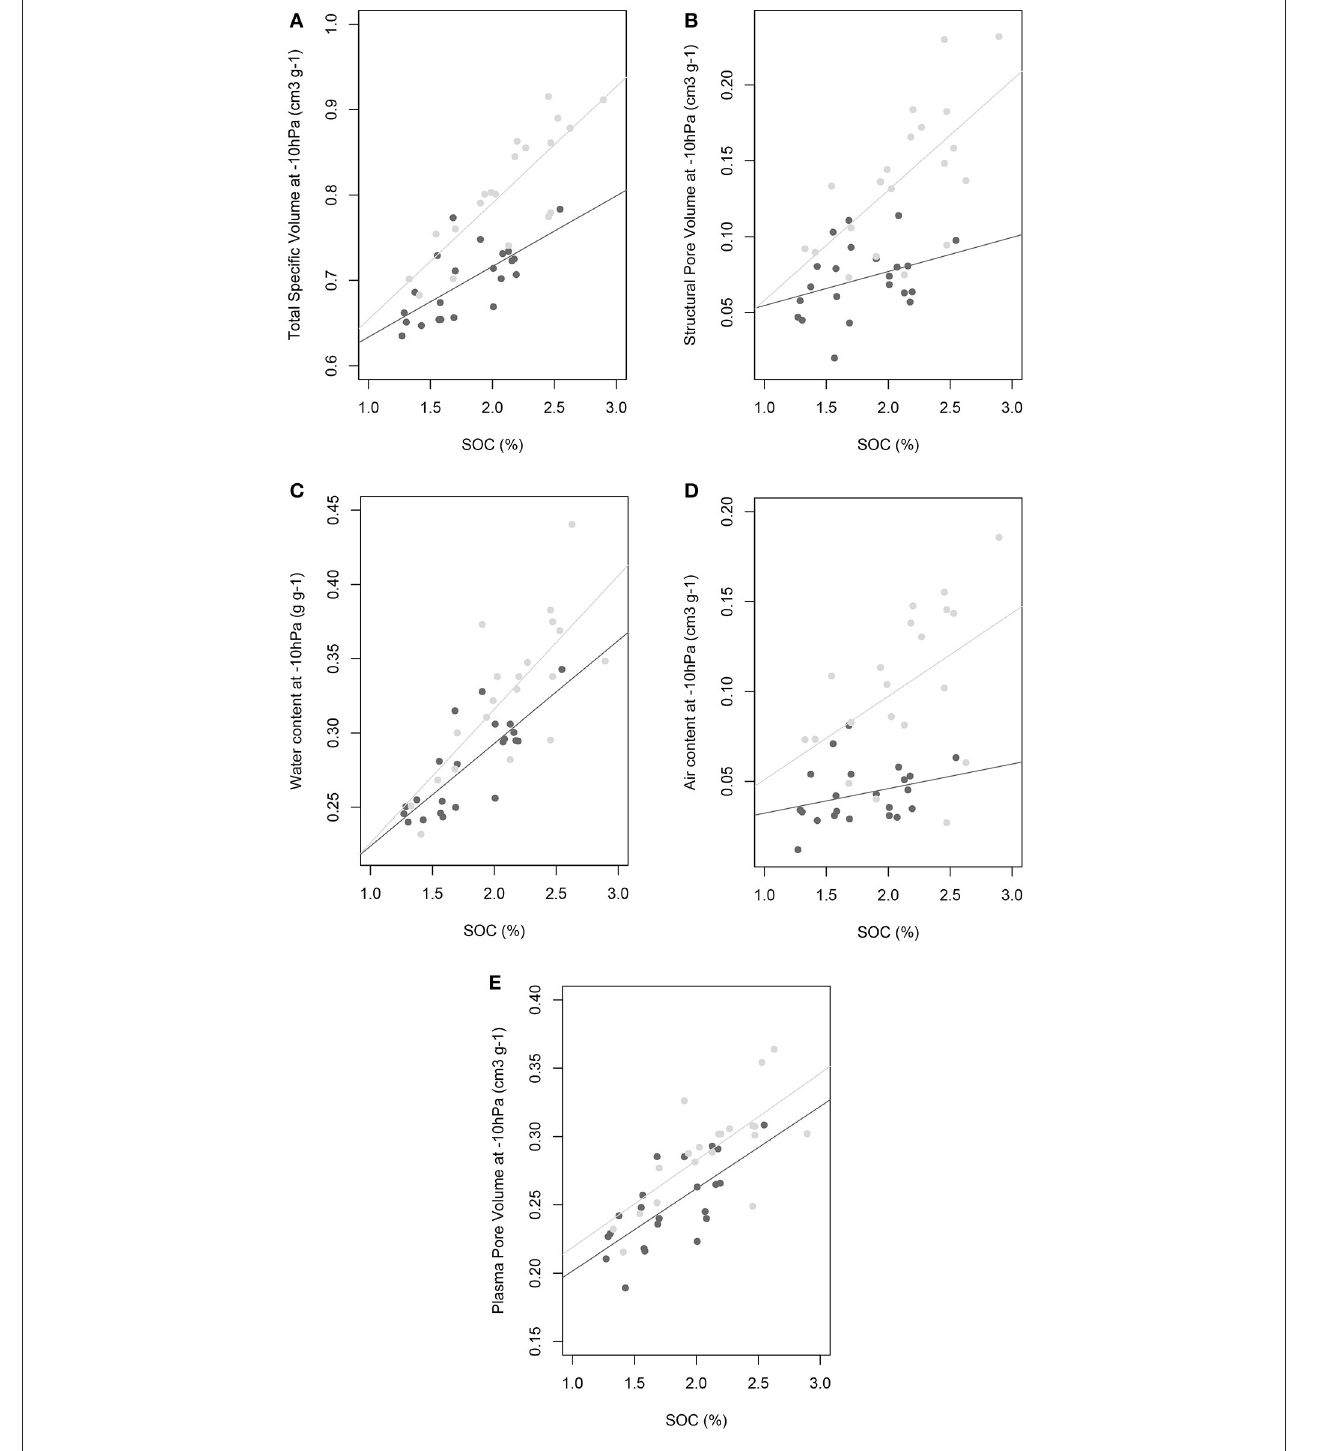
FIGURE 4 | Changes in the relationships between the soil properties at − 10 hPa and SOC during the experiment. Experimental observations and linear regressions. Changes in regressions slopes are significant except for plasma pore volume. Initial state in dark gray and final state in light gray: (A) specific volume; (B) Structural pore volume; (C) water content; (D) air content; (E) plasma pore volume.